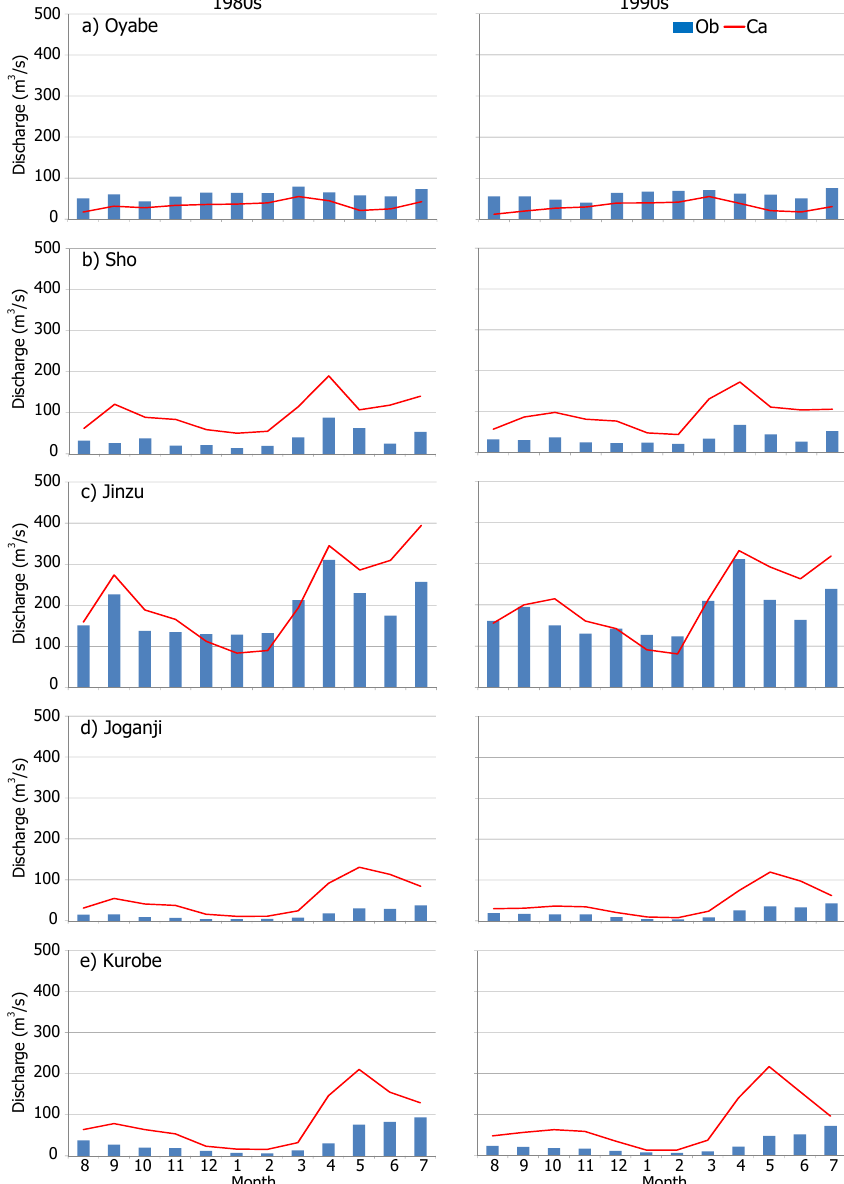
Fig. 3. Comparison of 10-year monthly mean discharge from observations and simulations for the five rivers in the 1980s and 1990s: (a) Oyabe River, (b) Sho River, (c) Jinzu River, (d) Joganji River, and (e) Kurobe River. (Ob: Observed discharge; Ca: Calculated discharge).